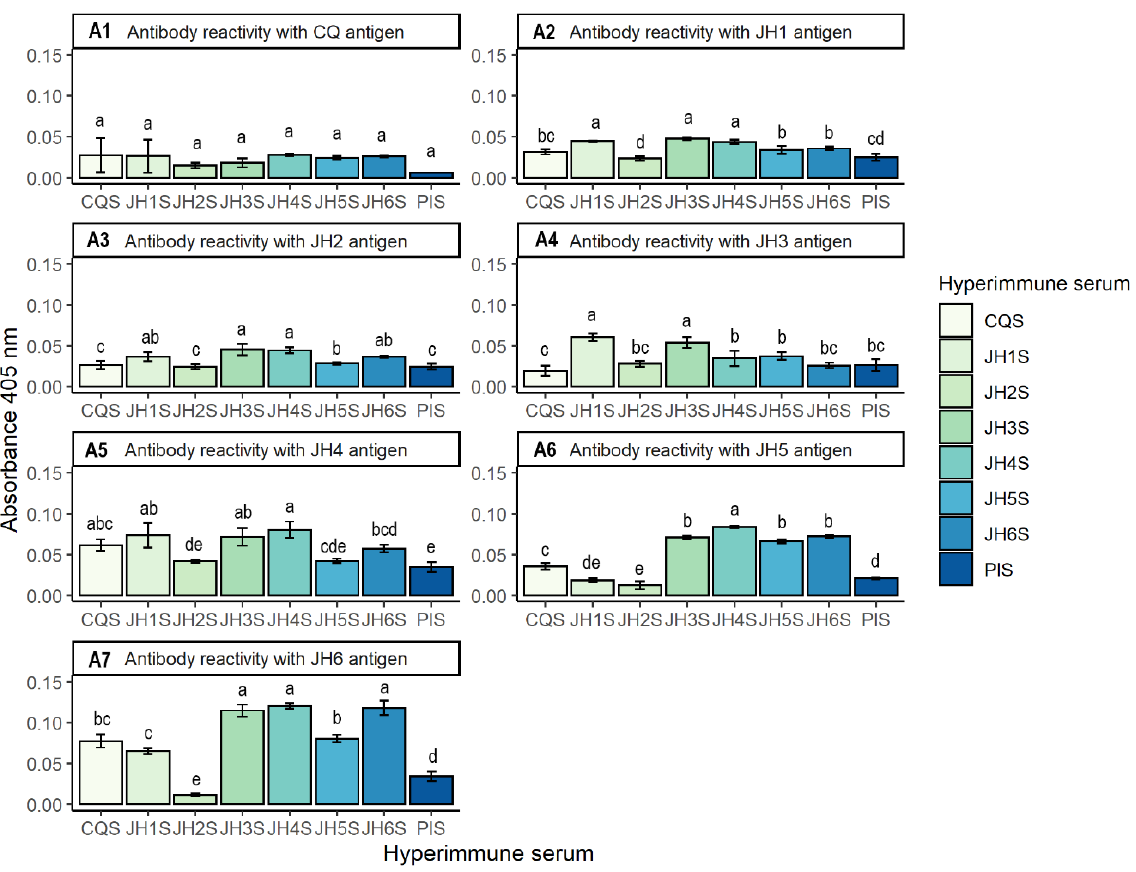
Figure 4. Results of indirect ELISA (Panels A1 , A2 , A3 , A4 , A5 , A6 and A7 ), with 10 µg/mL concentration of antigens (CQ, JH1, JH2, JH3, JH4, JH5 and JH6). On the X-axis are represented the 1:200 dilutions of the hyperimmune sera vs. absorbance at 405 nm on the Y-axis. The absorbances with the different antigens are represented in the same way in panels A2, A3, A4, A5, A6 and A7 for the bis-THTT JH1, JH2, JH3, JH4, JH5 and JH6,